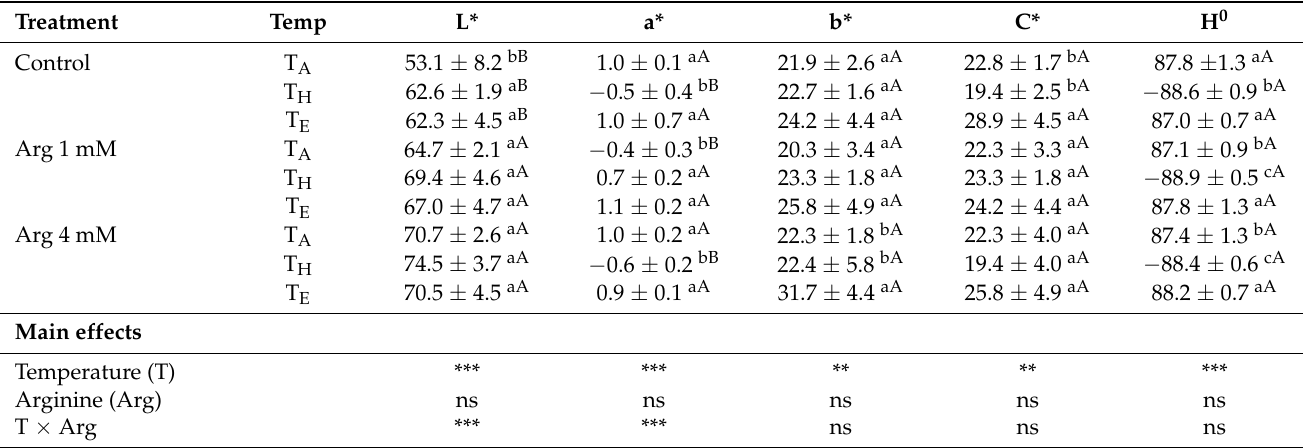
Table 1. Color parameters (lightness (L*), red-greenness (a*), blue-yellowness (b*), chroma (C*), and hue angle (H 0 ) values) of cauliflower florets as affected by short-term heat stress and foliar arginine application. Treatment